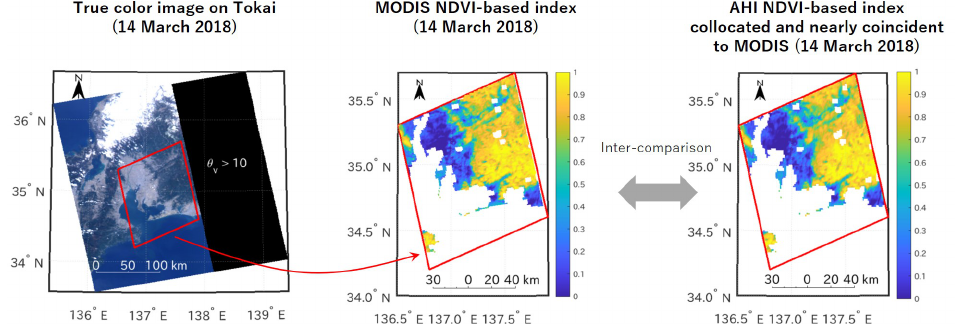
Figure 5. Illustration of the MODIS target area extraction process and NDVI-based indices comutations for 14 March 2018. The black area corresponds to pixels at which the viewing zenith angle exceeded 10 degrees ( left panel ). Shown are the NDVI-based indices computed using the algorithm introduced in Section 3 applied to MODIS data on the date ( center panel ) and the Normalized Difference Vegetation Index (NDVI)-based index computed using nearly coincident AHI data collocated to the MODIS data ( right panel